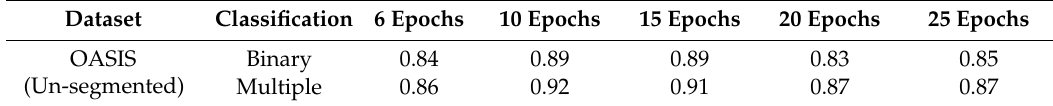
Table 2. Results of transfer learning for different numbers of Epochs.